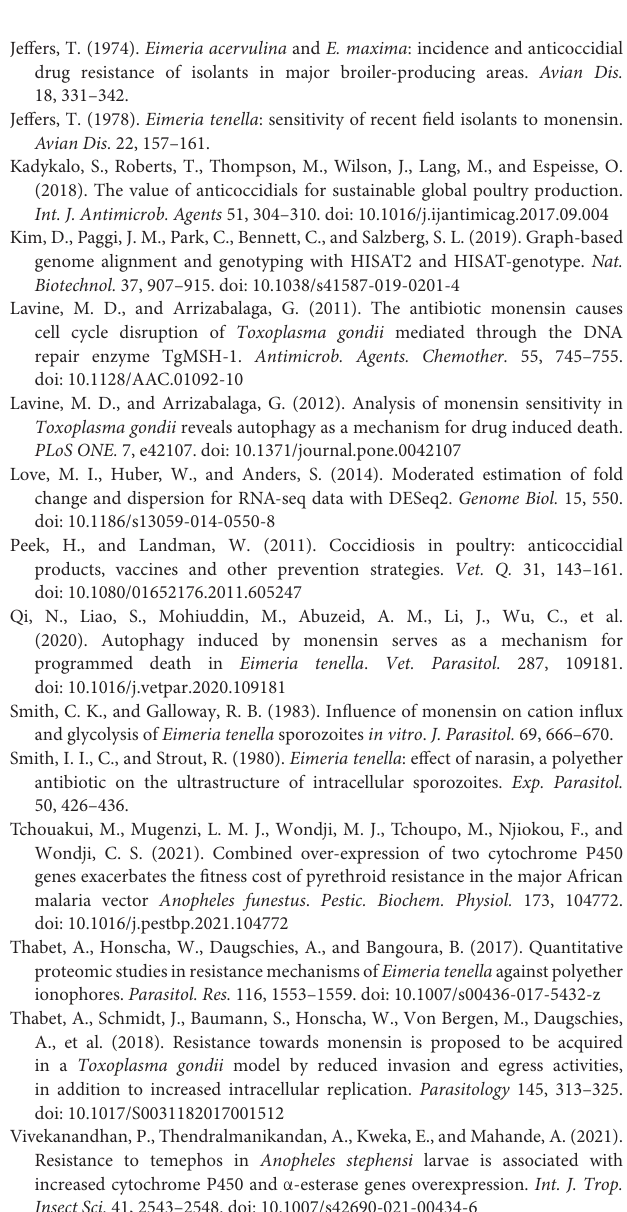
Supplementary Figure 1 | qPCR validation of differentially expressed genes. The expression of each gene was normalized to the EtGAPDH, and the unpaired two-tailed Student’s t-tests were used for statistical analysis. Supplementary Table 1 | Primers used in qPCR